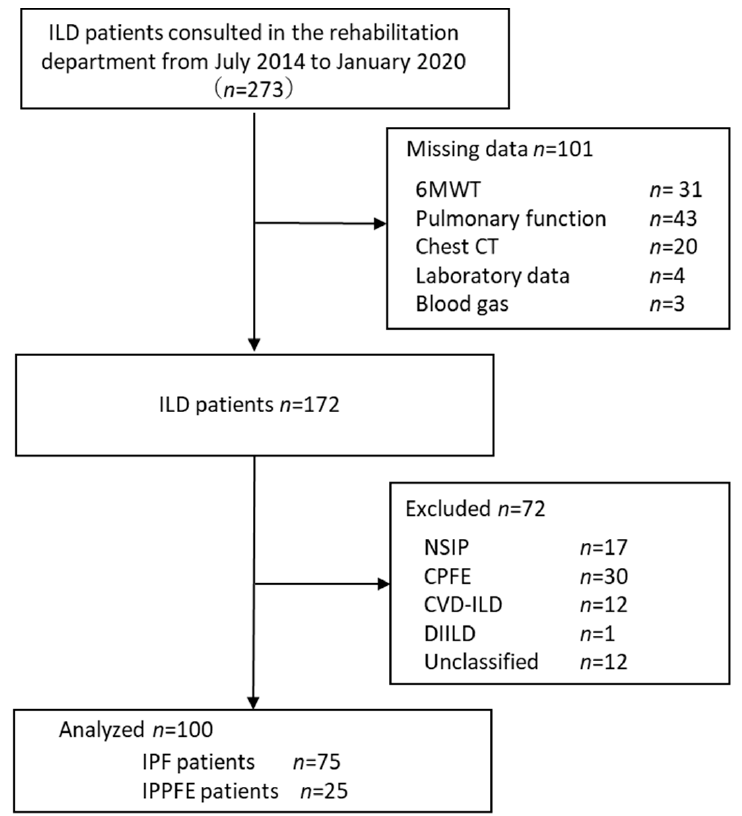
Figure 1. Flowchart of patient recruitment in this study. ILD, interstitial lung diseases; 6MWT, 6-minute walk test; chest CT, computed tomography; NSIP, nonspecific interstitial pneumonia; CPFE, combined pulmonary fibrosis and emphysema; CVD-ILD, collagen vascular disease–interstitial lung disease: DIILD, drug-induced interstitial lung disease; IPF, idiopathic pulmonary fibrosis; IPPFE, idiopathic pleuroparenchymal fibroelastosis.